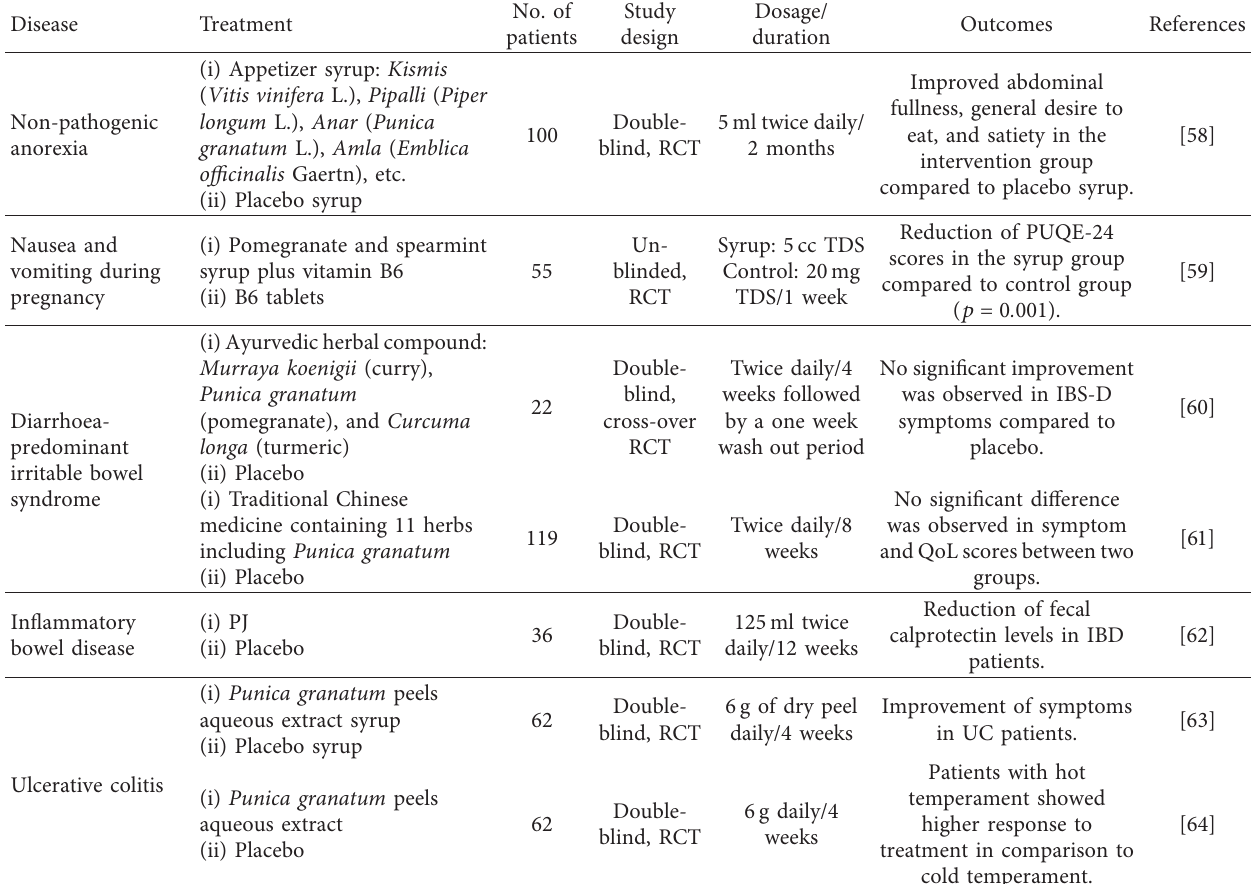
Table 2: Summary of clinical trials using Punica granatum (pomegranate) in gastrointestinal disorders. Disease